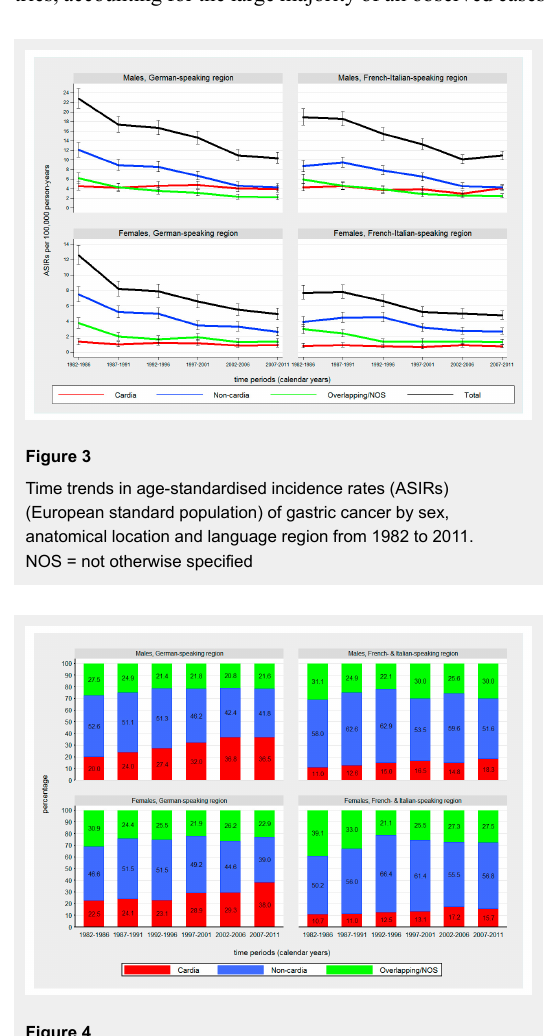
Table 1: Oesophageal and gastric cancer cases in Swiss cancer registries from 1982 to 2011. Cancer registry Diagnosis period Oesophageal cancer